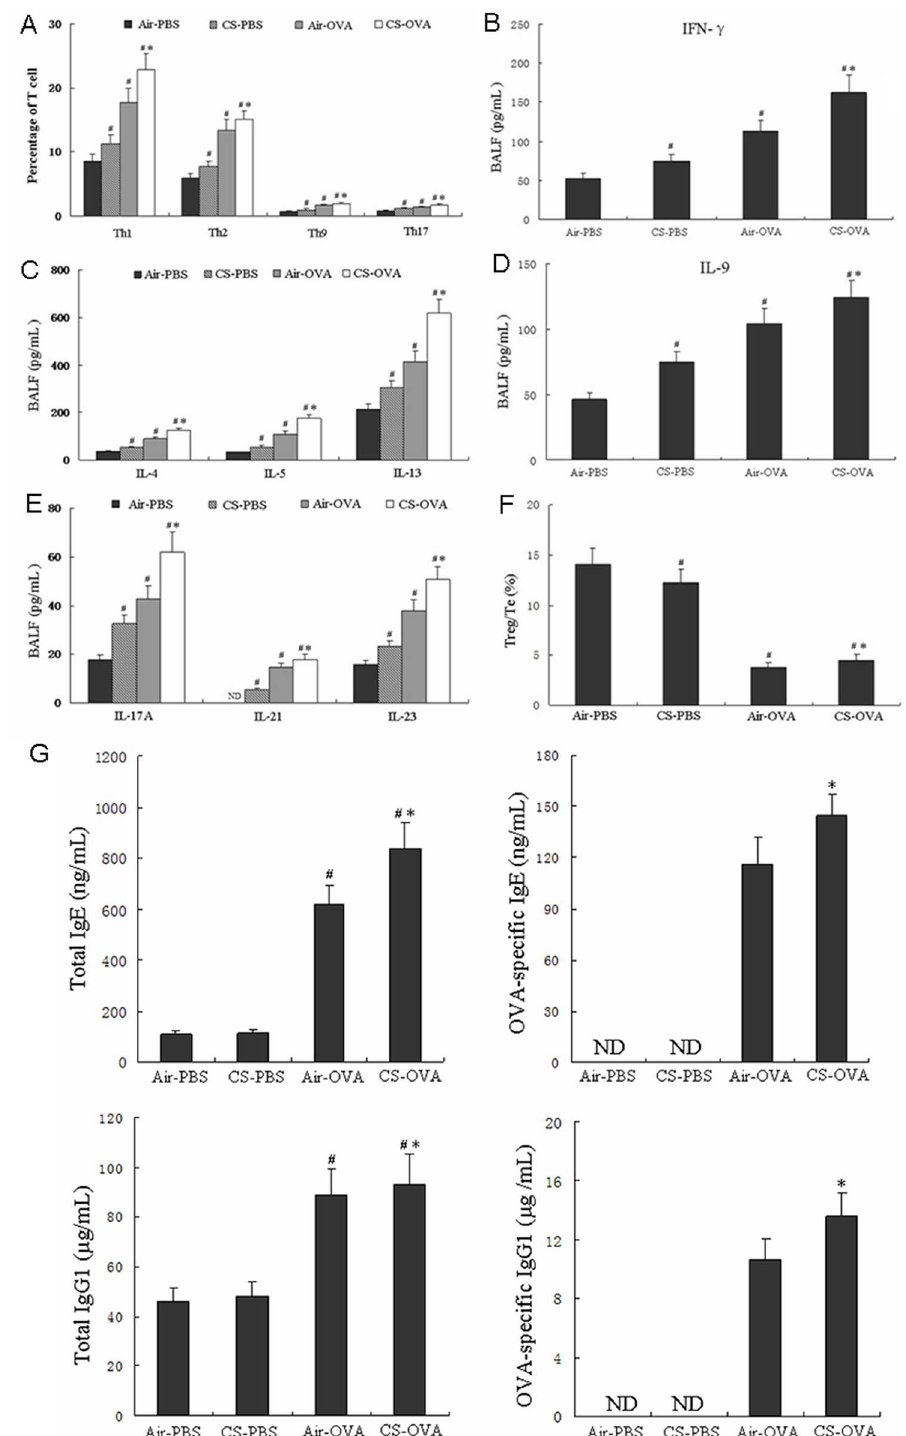
Fig 4. Early-life CS exposure suppressed cellular immunity. (A) The percentage of (CD4 + CD25 + ) Tregs was analyzedin lungs of the air-PBS, CS-PBS, air-OVA, and CS-OVA-treated mice. The cytokines INF- γ (B), IL-4, -5, and -14 (C), IL-9 (D), and IL-17, -21, -23 (E) were detected in BALF samples from the air-PBS, CS-PBS, air-OVA, and CS-OVA groups. The ratio of Treg/effector T cells (%) in the lungs were calculatedin F. (G) Serum antibody concentrations were determinedby ELISA in the same groups as above. All data were obtained by flow cytometric analysis, and the values are the means ± SD of the results from 6 mice per group. # P < 0.05 vs. Air-PBS group; * P < 0. 05 vs. Air-OVA group.